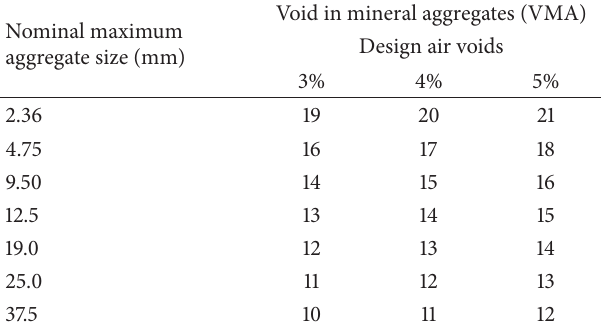
Table 5: Minimum VMA requirement (based on nominal maxi- mum aggregate size).